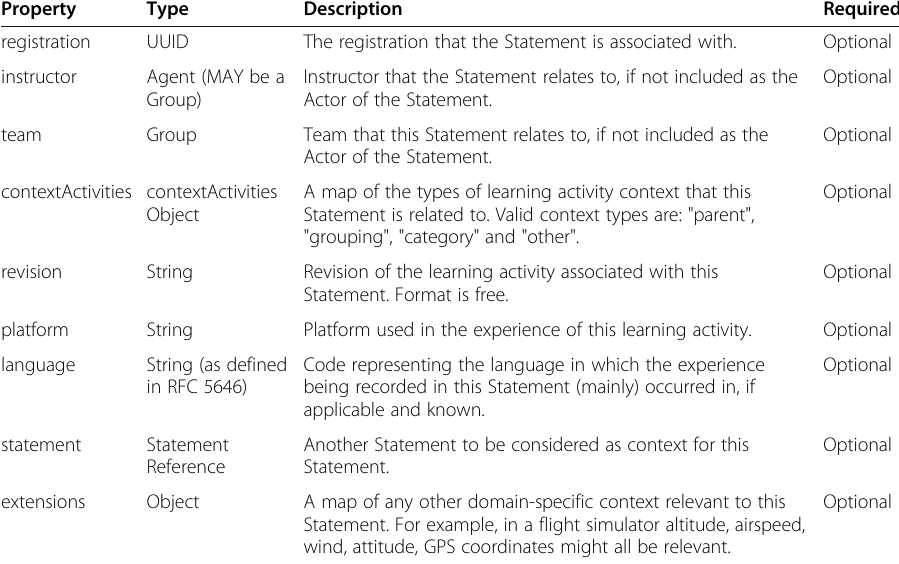
Table 1 Context structure properties (Advanced Distributed Learning,